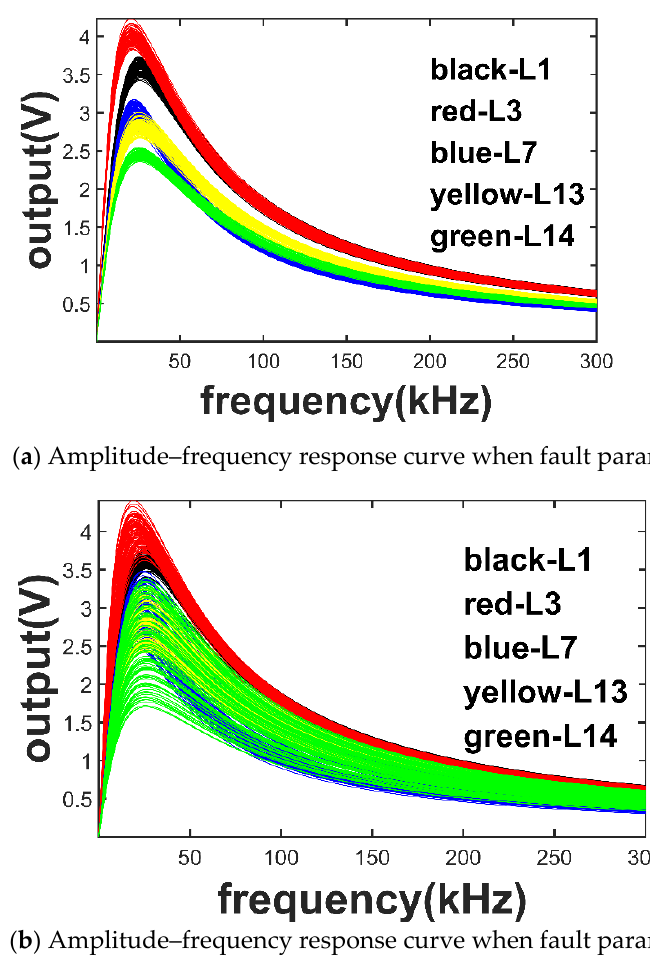
Figure 5. Amplitude–frequency response curves of several labels of faults in two cases.